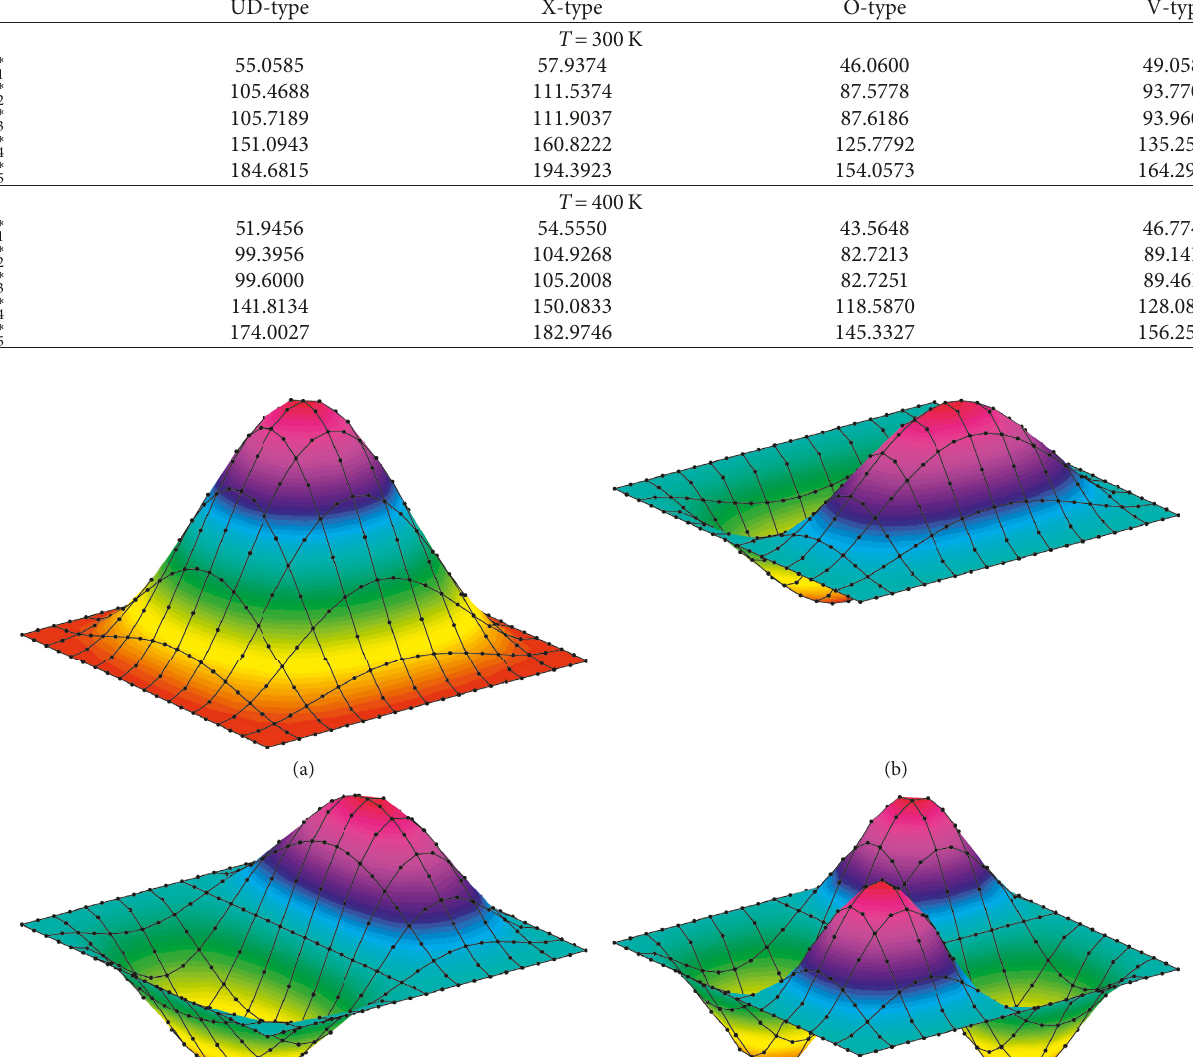
Table 4: The first five nondimensional fundamental frequencies of fully clamped shell.